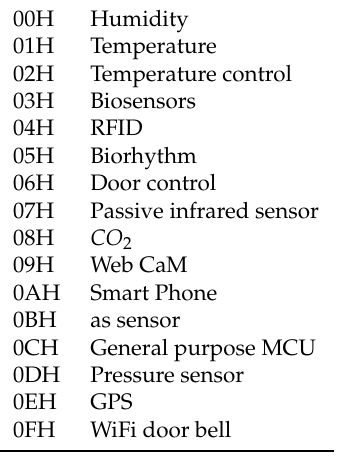
Table 1. Some examples of marker of sensor